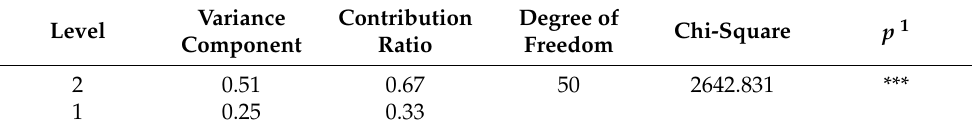
Table 2. Null model of the HLM result.